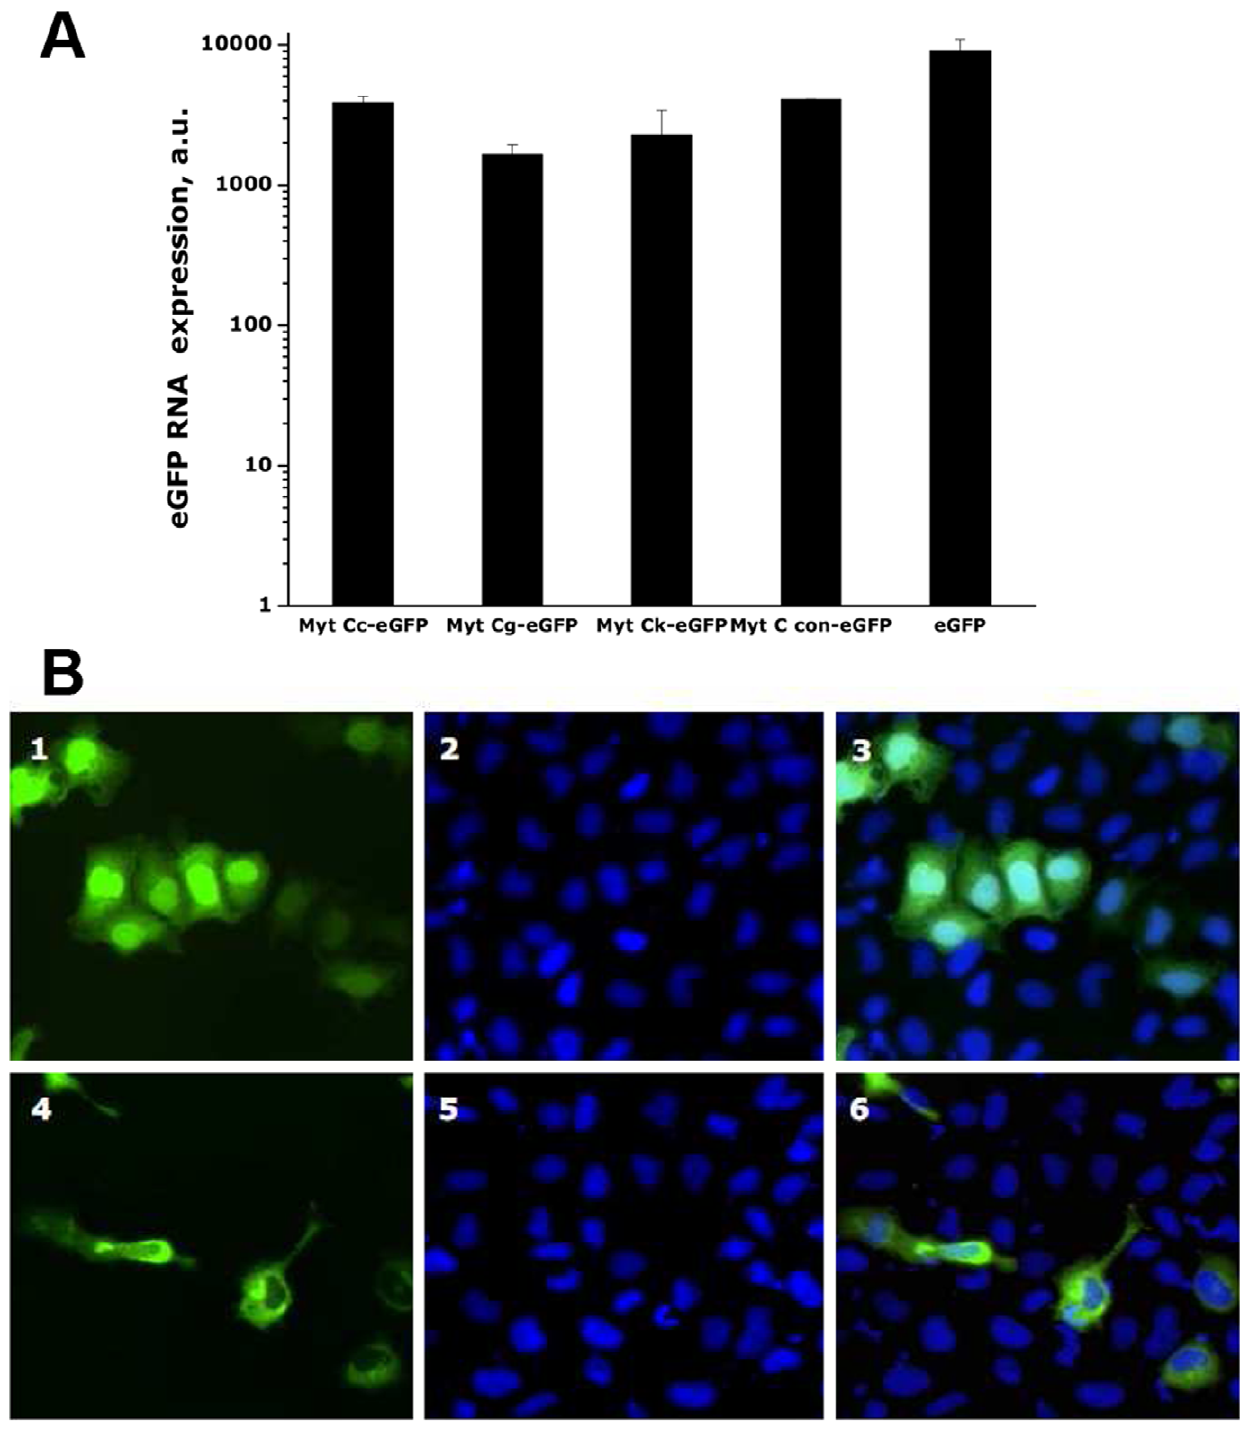
Figure 3. Recombinant expression of Myt C-eGFP variant C in CHSE cells. CHSE cells were transfected with pMCV1.4, pMCV1.4-eGFP or pMCV1.4-Myt Cc-eGFP plasmids, and expression of eGFP and Myt Cc-eGFP was assessed 24 h later at the transcriptional and protein levels. A, expression levels of transcripts of eGFP and Myt Cc-eGFP, Myt Cg-eGFP, Myt Ck-eGFP and Myt Ccon-eGFP evaluated by RT-qPCR using eGFP primers. The data are presented as the mean 6 S.D. of two independent experiments, each performed in duplicate. a.u; arbitrary units. B, CHSE expressing eGFP protein (upper panel) or Myt Cc-eGFP fusion protein (lower panel). CHSE micrographs at fluorescent (1,4); UV (2,5); (3,6) merged image of fields 1 and 2.